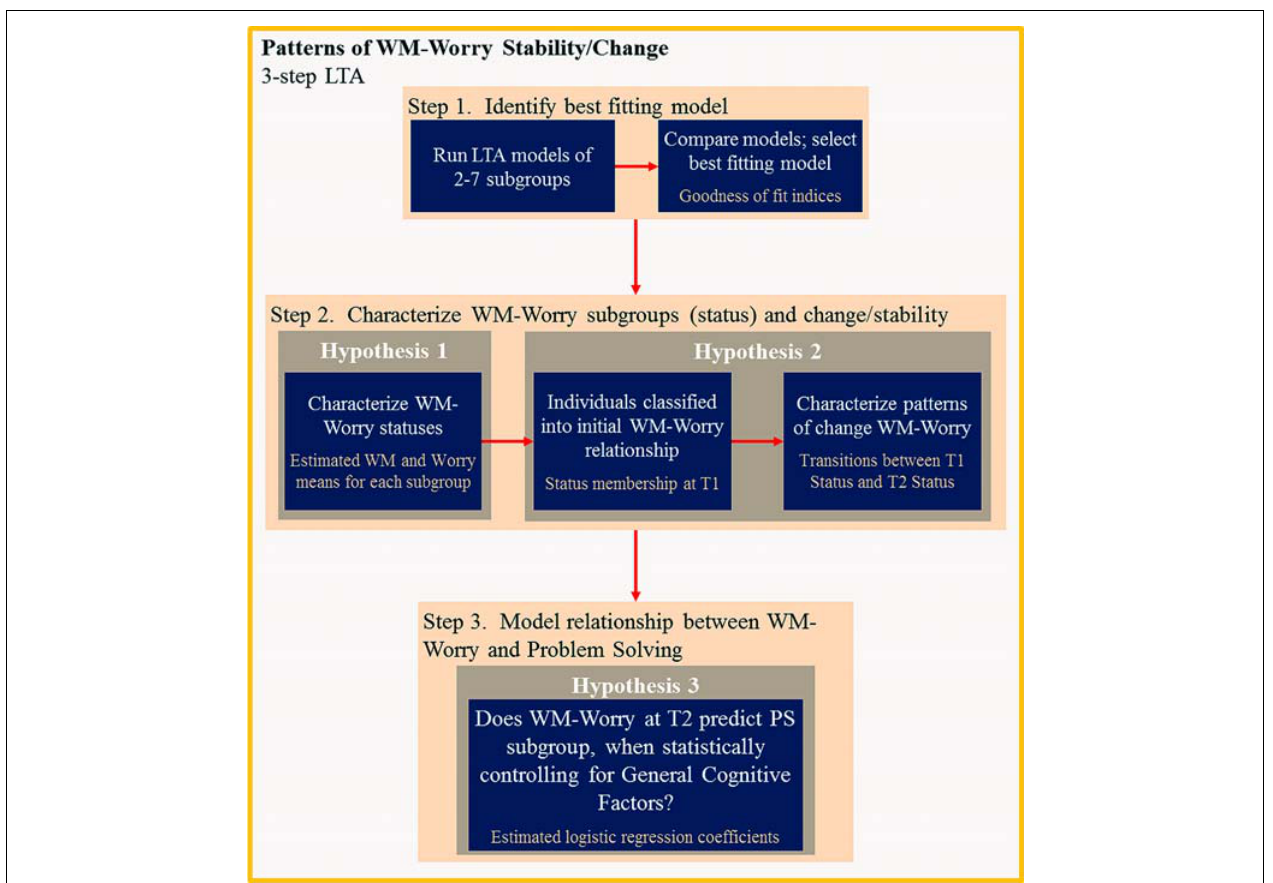
FIGURE 3 | Flow chart of data analysis process. T1,Time 1;T2,Time 2; PS, problem solving.